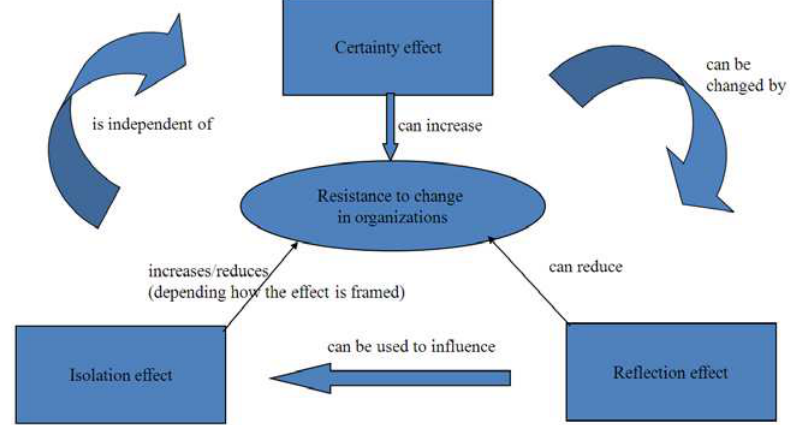
Fig. 2. Resistance to change in